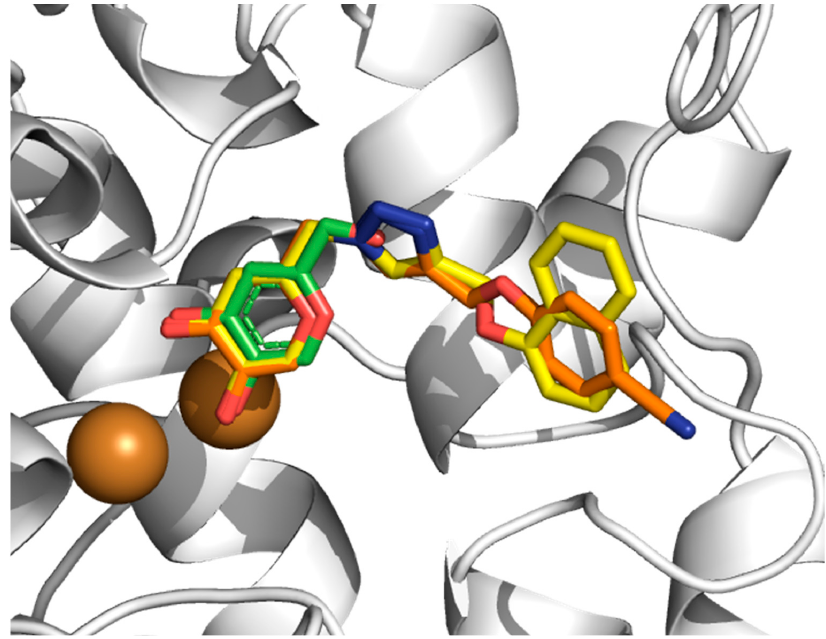
Figure 2. Three-dimensional overlapping of KA (green), 6h (orange) and 6o (yellow) into TYR Bm catalytic site by molecular docking. Cu 2+ ions are shown as brown spheres. H atoms are omitted for clarity. All PDB files are provided as Supplementary Materials. Table 1. Molecular docking results (MOLDOCK scoring, Kcal/mol) and experimental activity (IC 50 , µM) of KA analogs in complex with TYR Bm .